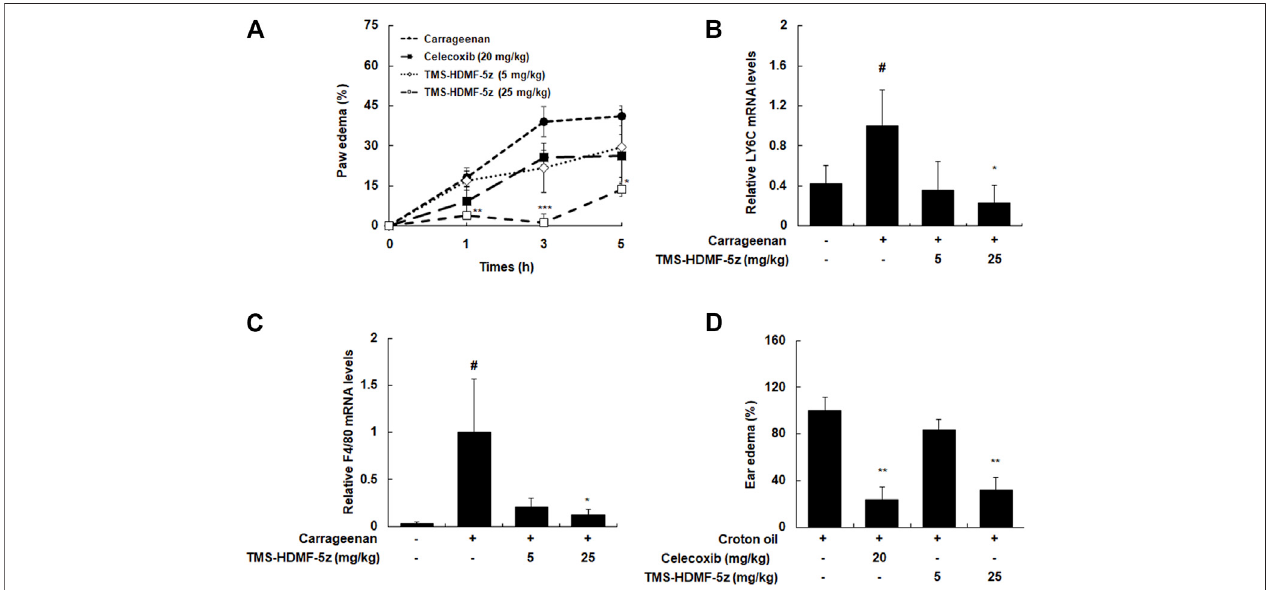
FIGURE 6 | Inhibitory effects of TMS-HDMF-5z administration on carrageenan-induced paw edema and croton oil-stimulated ear edema in rats. (A) Paw edema volumes were measured at 1, 3, and 5 h after injection using a plethysmometer. Celecoxib, an anti-in fl ammatory drug, was used as a positive control. (B,C) Total RNAs werepreparedfromcarrageenan-inducedpawtissuesat5 handanalyzedforthemRNAexpressionofLy6CandF4/80byqRT-PCR.ThelevelsofLy6CandF4/80were normalized to ß -actin expression. Dataare shown asthe mean ±S.D ( n =6); # p < 0.05 vs . control group, *p < 0.05 vs . thecarrageenan only-treated group. (D) Ear edemavolumesweremeasuredat3 haftercrotonoilapplicationusingacaliper.Celecoxibwasusedasapositivecontrol.Dataareshownasthemean±S.D( n =6). **p < 0.01 vs . the croton oil only-treated group.